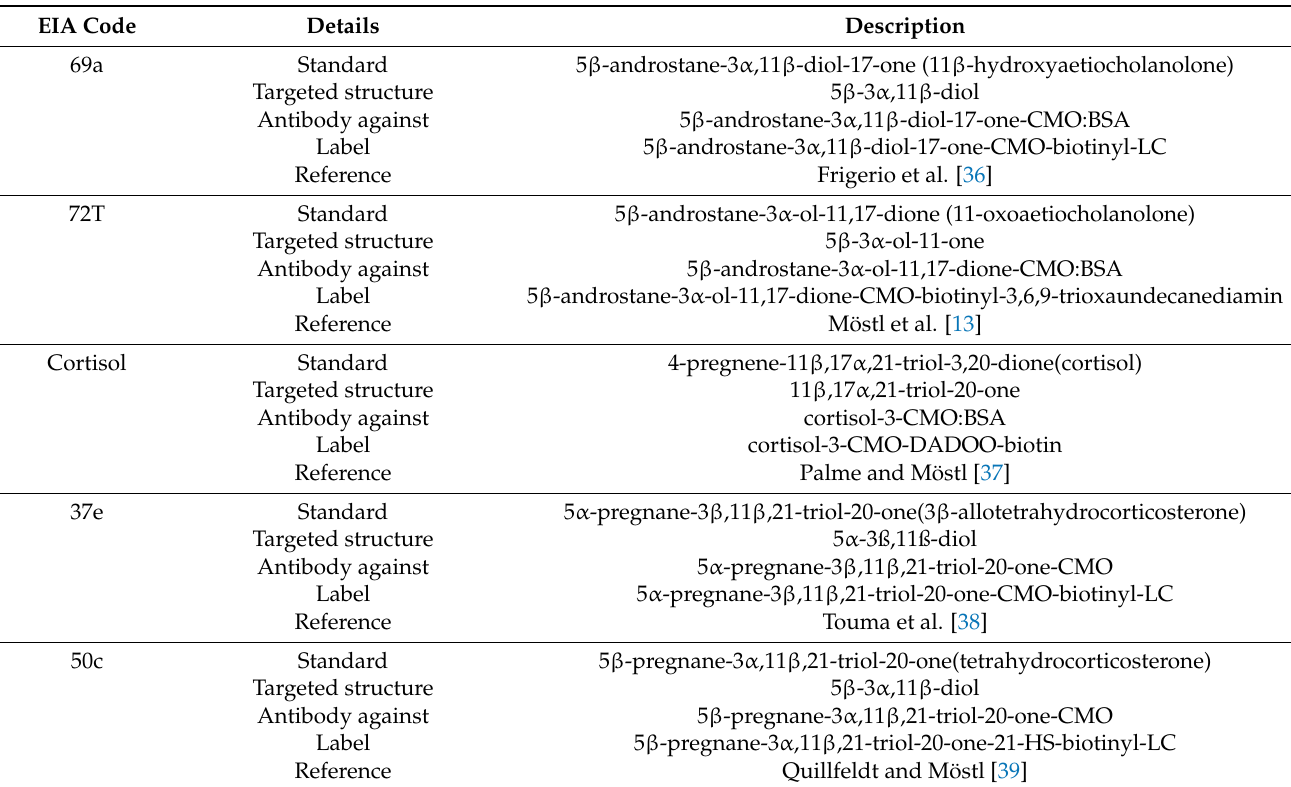
Table 4. Details of the EIAs utilized in the current